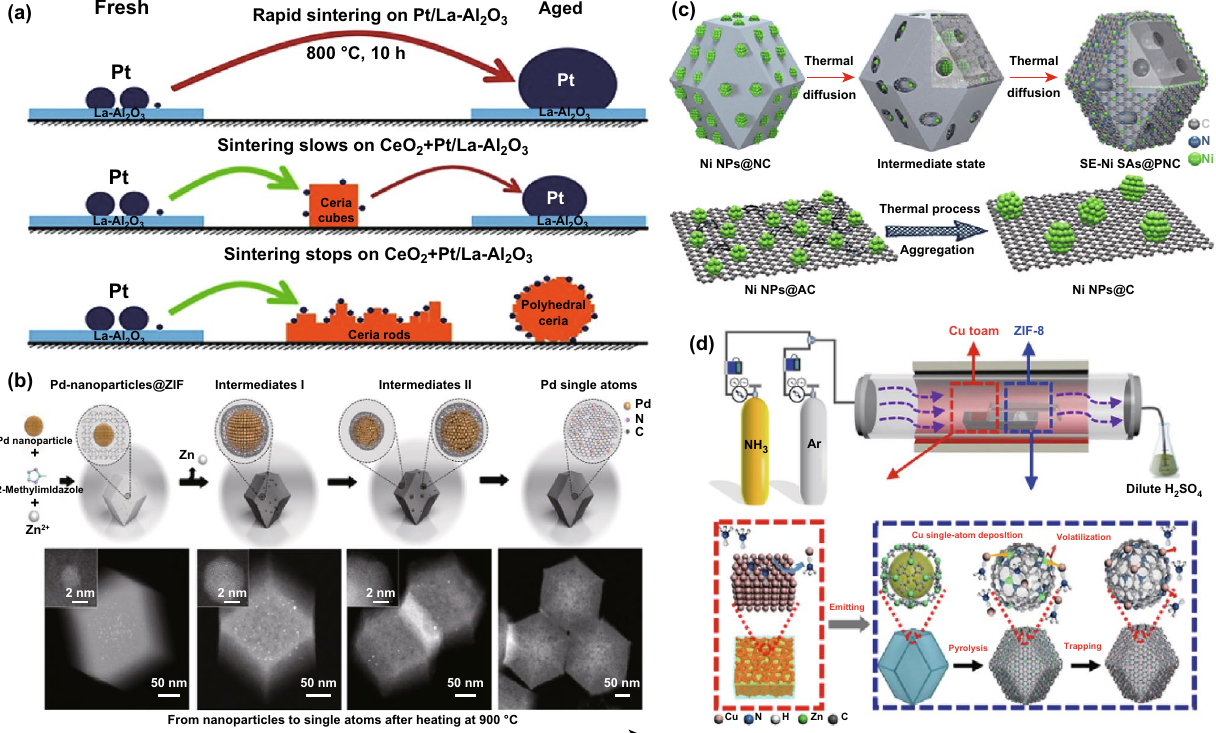
Fig. 6 a Schematic illustration of Pt nanoparticle to Pt SACs. b Schematic illustration of Pd nanoparticle to Pd SACs and structural charac- terizations of Pd SACs. c Scheme of Ni NPs to Ni SACs transformation and structural characterizations. d Schematic of the synthesis of Cu SACs/N–C. a Reproduced from Ref. [156] with permission. Copyright 2016 American Association for the Advancement of Science. c Repro- duced from Ref. [158] with permission. Copyright 2018 Wiley-VCH. b , d Reproduced from Refs. [157, 159] with permission. Copyright